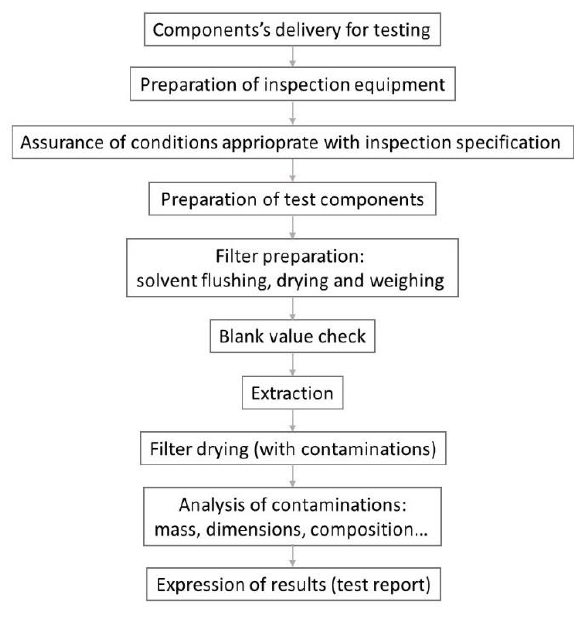
Fig. 5. Cleanliness inspection